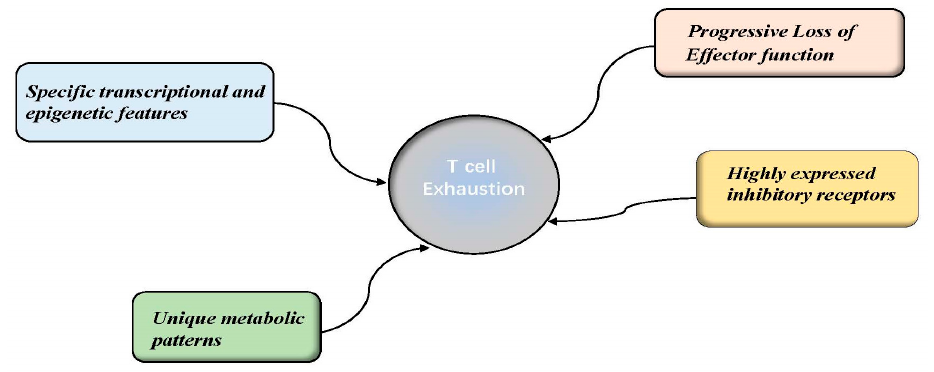
Figure A3. A representative figure of the features of the T cell exhaustion. After long- term exposure to antigen in the chronic viral infection and cancer, T cells largely tend to drive a different differentiation program. Intermediate exhausted T cells display specific features distinct from those of effector or memory T cells, including progressive loss of effector function, highly expressed inhibitory receptors and specific transcriptional and epigenetic regulation. For instance, the terminal stage of exhaustion leads to partial or complete inability of T cells to pro-duce large amounts of IFN- γ , β -chemokines, or to carry out degranulation and highly co-expressed of various inhibitory receptors (IRs), including programmed cell death protein 1 (PD-1), cytotoxic T lymphocyte-associated antigen-4 (CTLA-4), lymphocyte-activation gene 3 (LAG-3), T cell immunoreceptor with immunoglobulin, and so